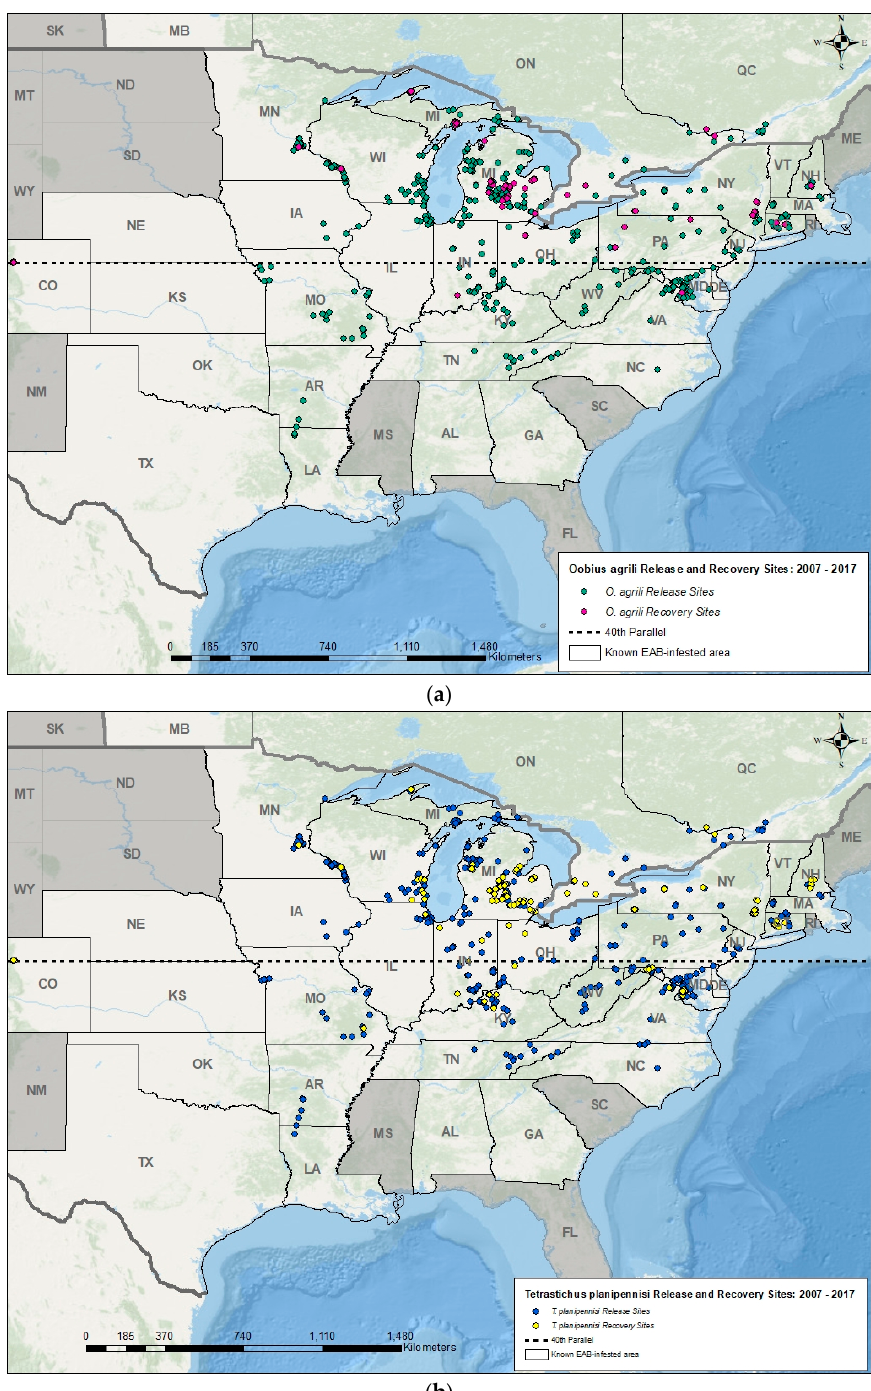
Figure 2. Maps showing known regions of North America invaded by EAB, and the release and recovery sites for ( a ) O. agrili and ( b ) T. planipennisi , EAB biocontrol agents introduced from China in North America from 2007 to 2017, using a variety of methods [83] and documented on the EAB biocontrol geospatial database [84]. In the United States, releases of T. planipennisi and O. agrili began in 2007, and in Canada, releases of these species began in 2013 and 2015, respectively. Establishment of these two biocontrol agents in EAB populations are confirmed at many early release sites.